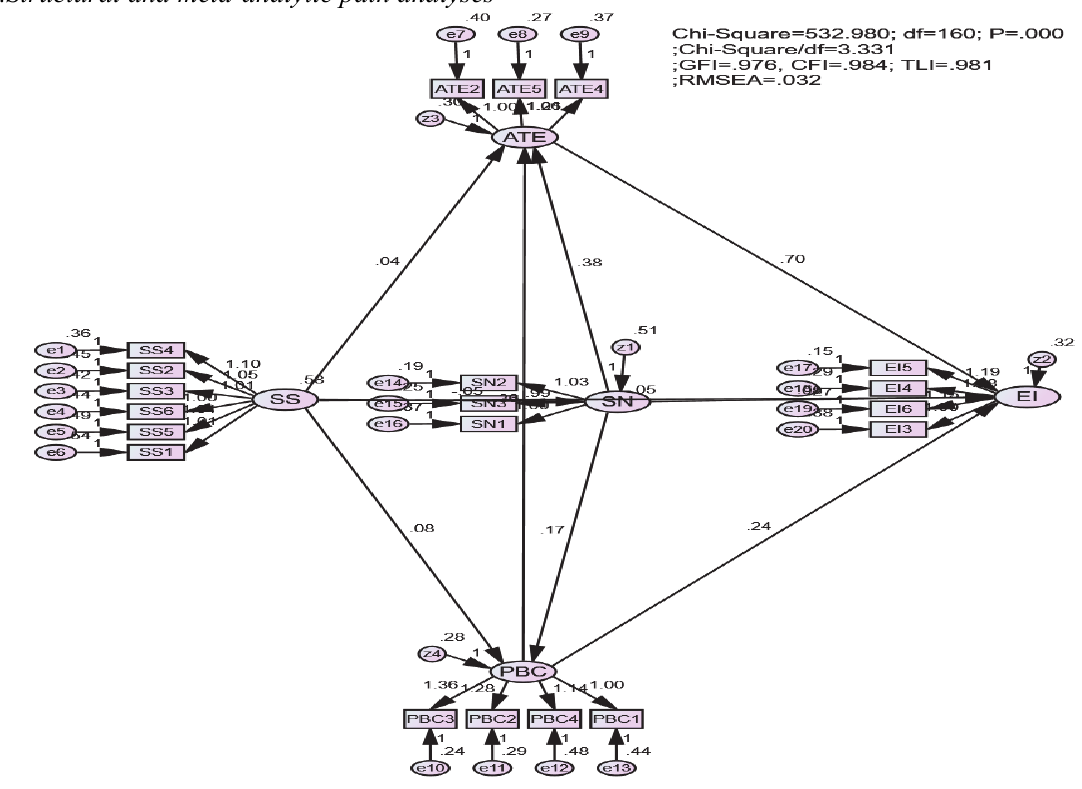
Fig. 3. The results of structural analyses (unstandardized